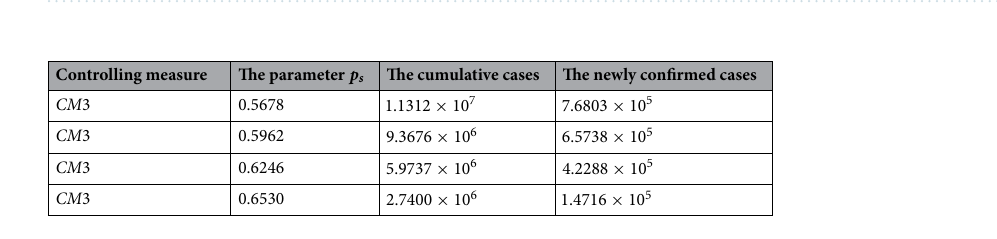
Table 11. The effect of the CM 6 on the cumulative cases.